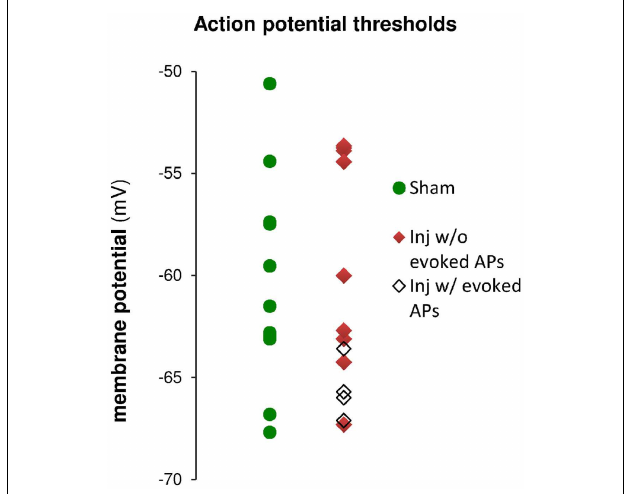
FIGURE 9 |Action potential (AP) thresholds measured by current injection through the whole-cell recording electrode during current clamp recordings in cells from sham and injured animals .The range of action potential thresholds overlapped, and the mean values were not different between cells from sham and injured animals (see also Table 1 ), indicating no change in pyramidal neuron AP threshold after injury. Note that the injured cells in which stimulus-evoked action potentials could be triggered off the EPSP were those cells for which the AP threshold was near the low end of the AP threshold range, closer to E GABA